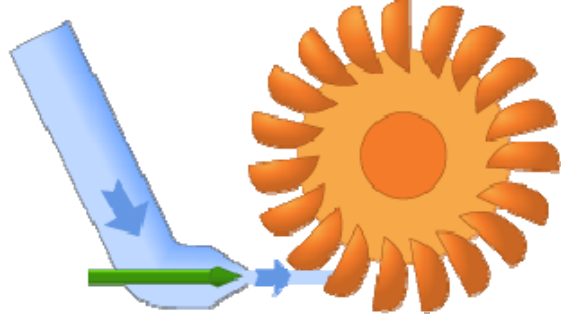
Figure 9. Pelton turbine.